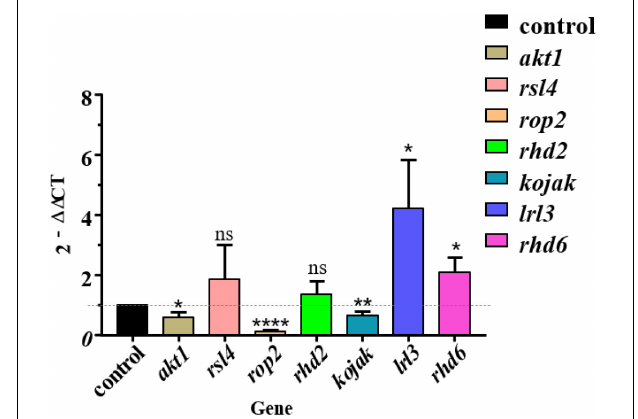
involved in root development in A . thaliana after colonization of S . lincolnensis L4. Expression of four genes lrl3 and rhd6 were upregulated in the L4 treatment group compared with the control group; expression of three genes akt1 , kojak , and rop2 were decreased; rsl4 and rhd2 have no significant difference compared with the control group. The “2 − (cid:49)(cid:49) C T ” method was used for calculating the expression change of target genes with 18S rRNA gene as housekeeping gene, in which 2 − (cid:49)(cid:49) C T > 1 or < 1 represents the upregulation or downregulation of target genes. The significances were presented by * P < 0.05; ** P < 0.01; **** P <